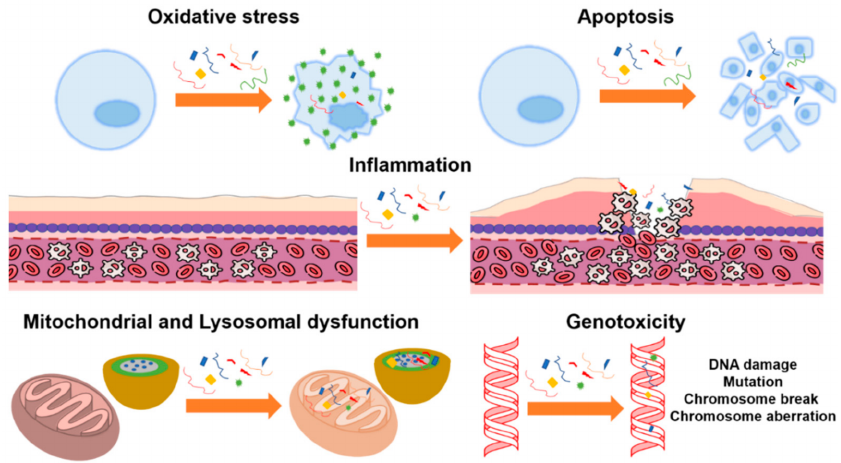
Figure 3. Toxicological effects of polystyrene microparticles on cell cultures: oxidative stress, apopto- sis, inflammation, mitochondrial and lysosomal dysfunction, and